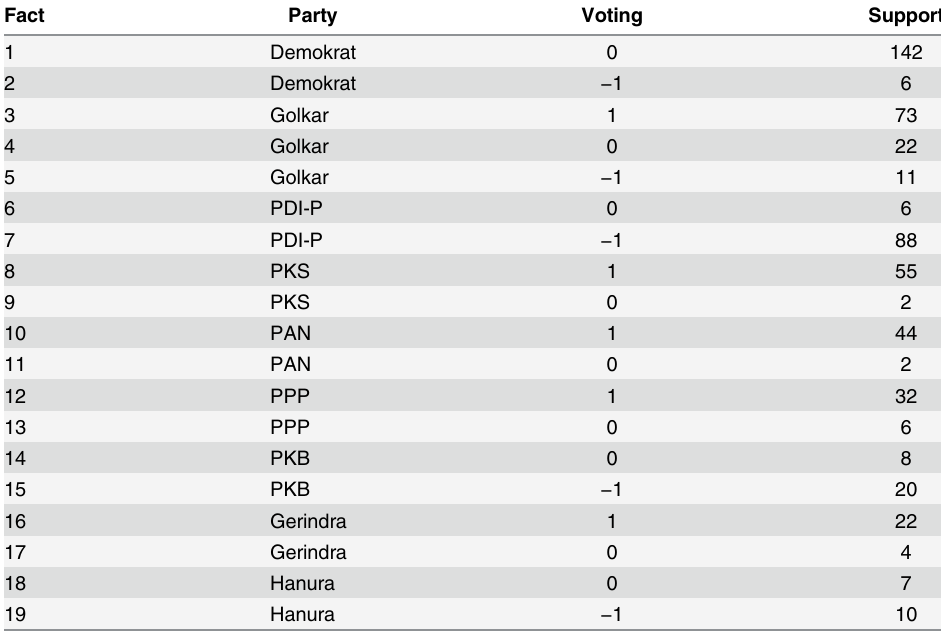
Table 20. Support of all facts of Indonesian Parties in Fig 8. Fact